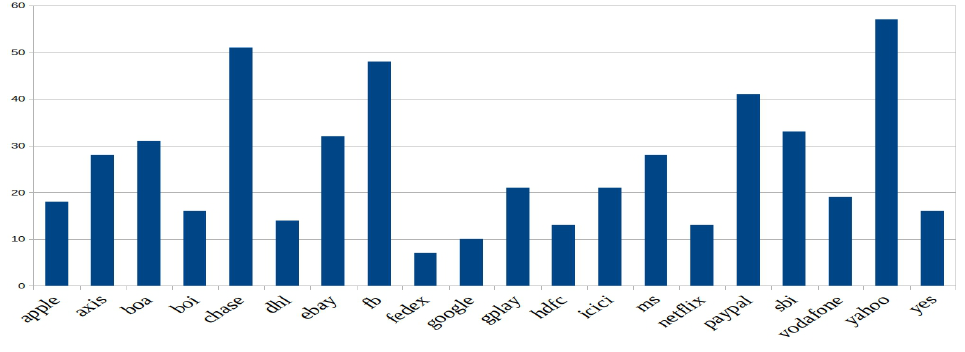
Figure 9. Class-wise logo image distribution.